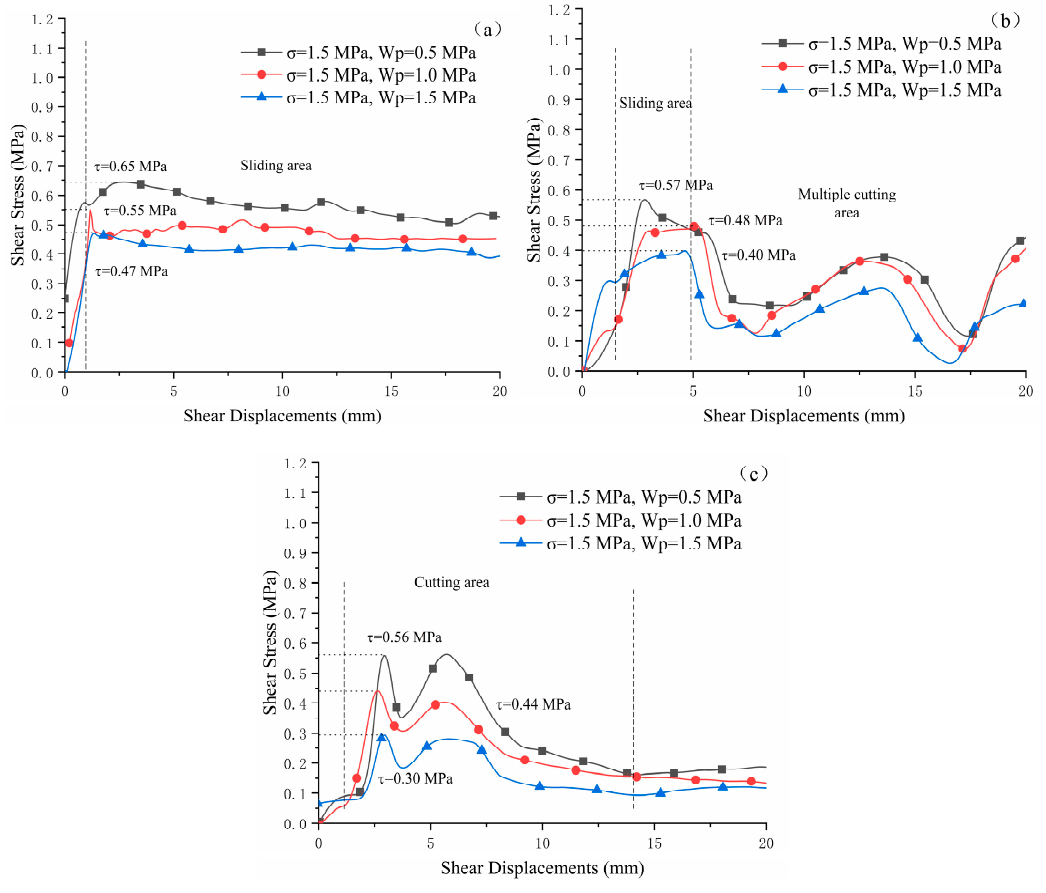
Figure 5. Shear deformation curves of joint surfaces under different seepage pressures when normal stress is 1.5 MPa: ( a ) joint roughness is 0°; ( b ) joint roughness is 15°; ( c ) joint roughness is 30°.